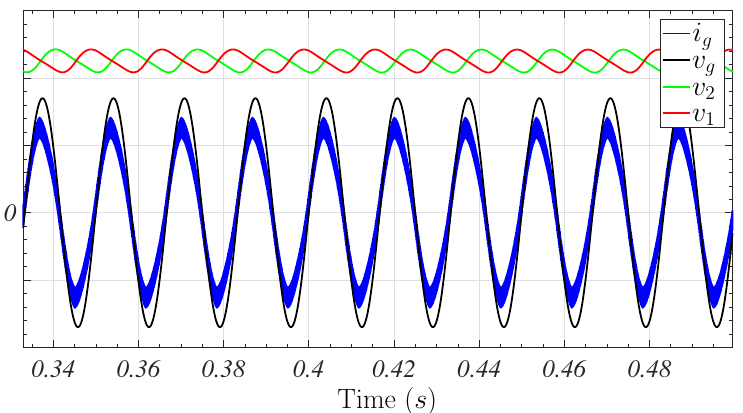
Figure 17. Waveforms obtained for CV2; i g : 1 A/div, v g , v 1 and v 2 : 100 V/div.